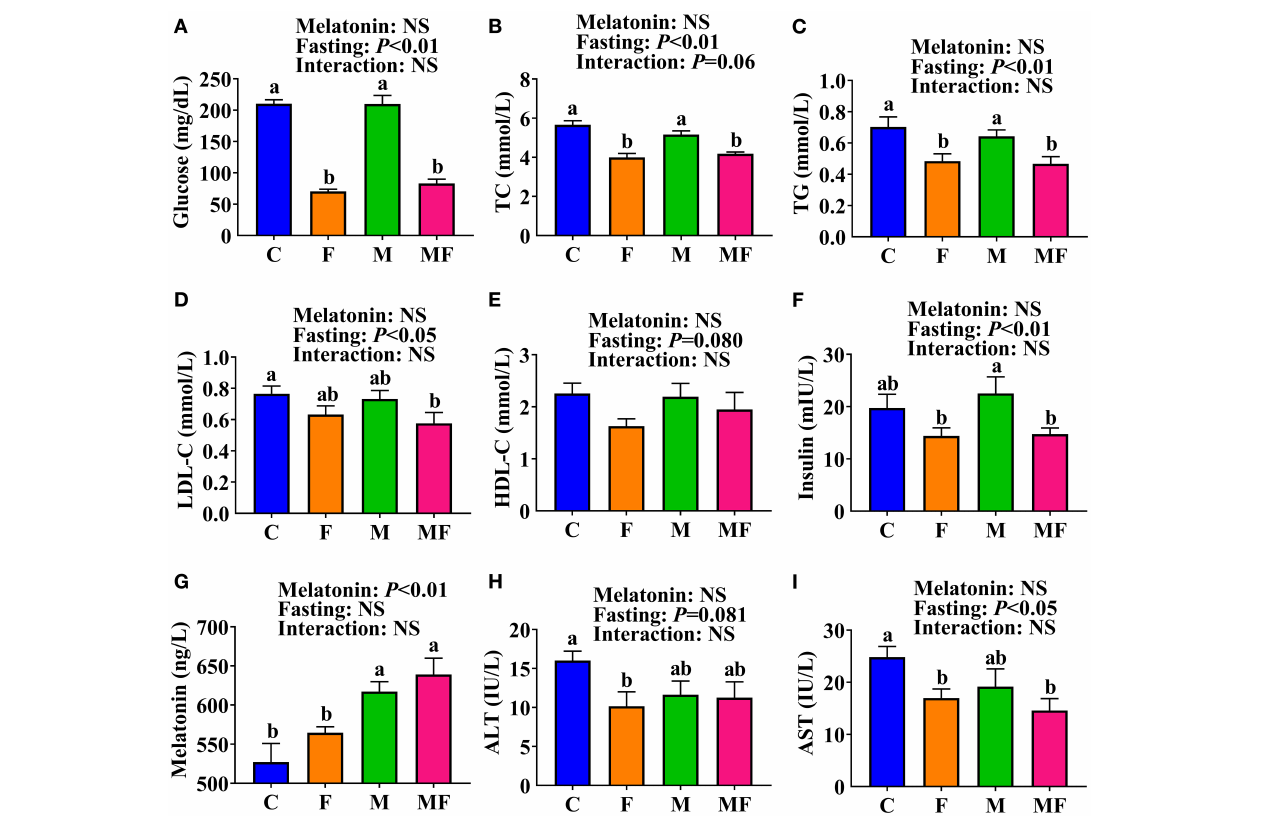
FIGURE 2 | The effects of intermittent fasting and melatonin supplementation on serum indexes in mice. (A) Glucose; (B) TC; (C) TG; (D) LDL-C; (E) HDL-C; (F) Insulin; (G) Melatonin; (H) ALT; (I) AST. Data are presented as mean ± SEM, n = 8 ∼ 12. Labeled means without a common letter differ ( P < 0.05), NS: P ≥ 0.05. C, control; F, intermittent fasting; M, melatonin; MF, intermittent fasting plus melatonin. The C and M mice were fed ad libitum , while the F and MF groups underwent alternative-day feed deprivation. The M and MF groups mice were supplemented with melatonin at a dose of 10 mg/kg body weight by drinking. ALT, alanine aminotransferase; AST, aspartate aminotransferase; HDL-C, high density lipoproteins cholesterol; LDL-C, low density lipoproteins cholesterol; TC, total cholesterol; TG,